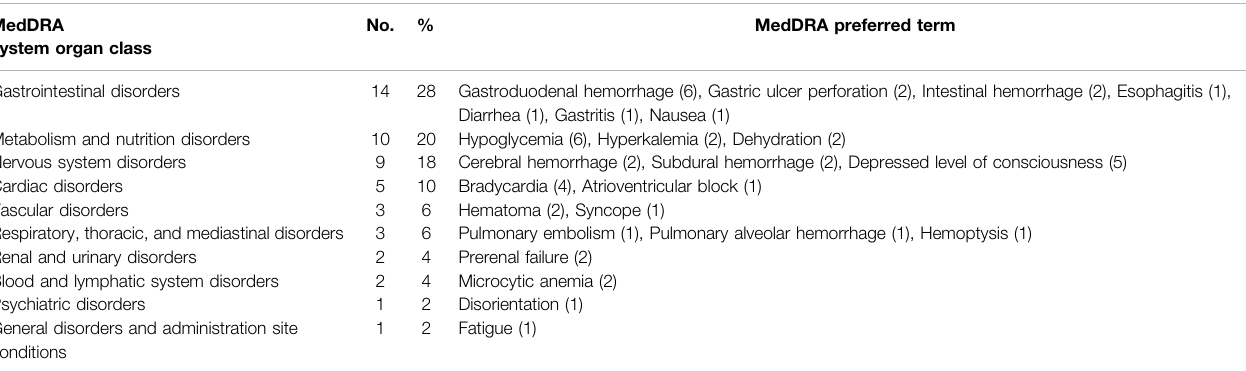
TABLE 14 | MedDRA categories of preventable DRAs related to treatment safety (N = 50). MedDRA system organ